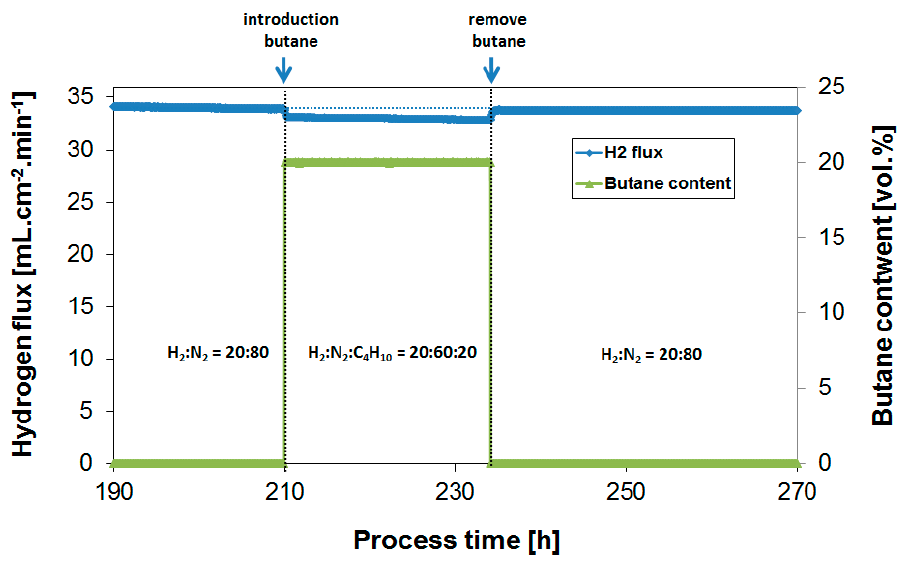
Figure 2. H 2 flux during butane introduction (20%) and overnight exposure to a feed mixture of H 2 :N 2 :C 4 H 10 = 20:60:20. Temperature = 400 °C. H 2 :N 2 :C 4 H 10 = 20:60:20. Temperature = 400 ◦